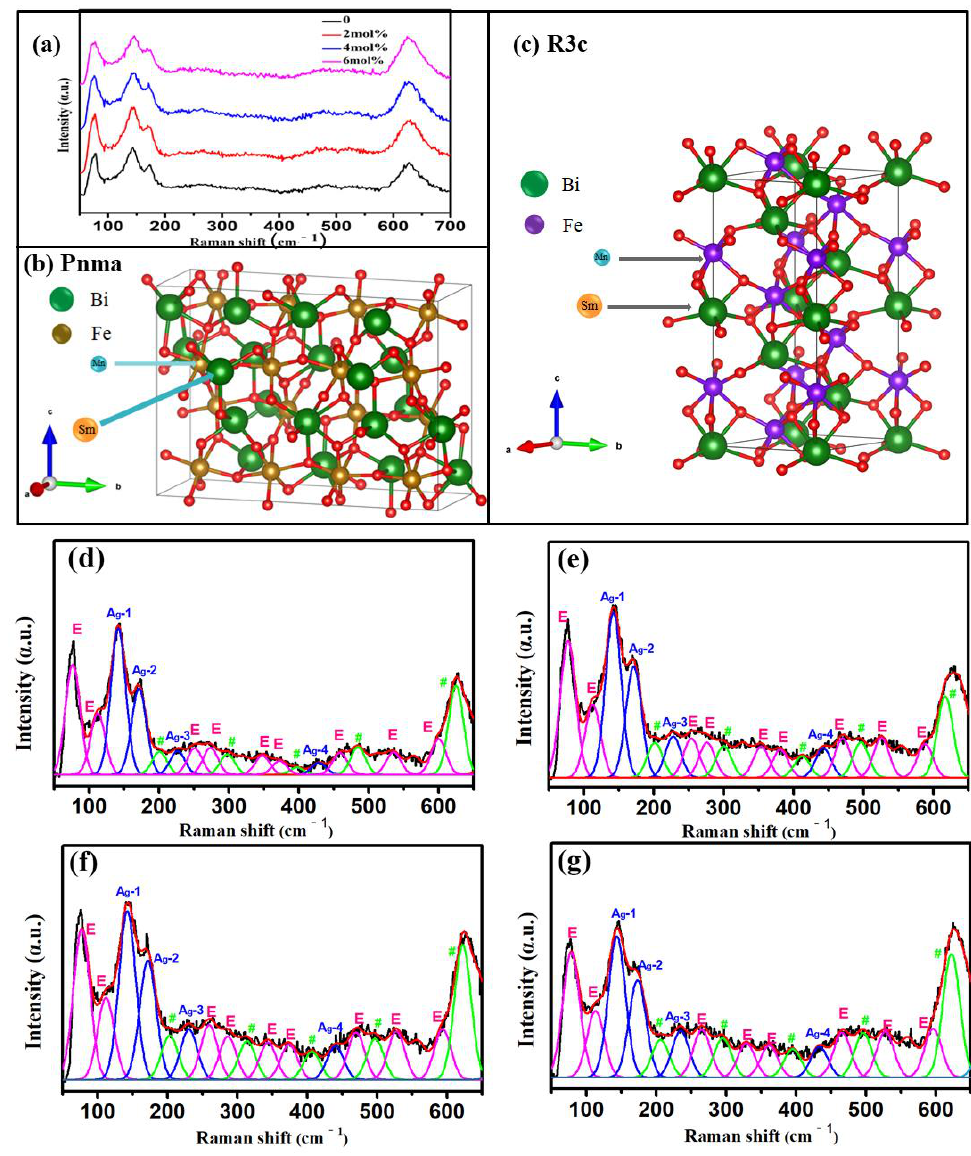
Figure 4. ( a ) Raman spectra of the BSFM films with different Sm content and crystal structure of the BSFM films: ( b ) Pnma; ( c ) R3c, Raman fitting spectra of the BSFM films with different Sm content: ( d ) x = 0 mol%; ( e ) x = 2 mol%; ( f ) x = 4 mol%; ( g ) x = 6 mol%. # refers to the Raman frequencies of